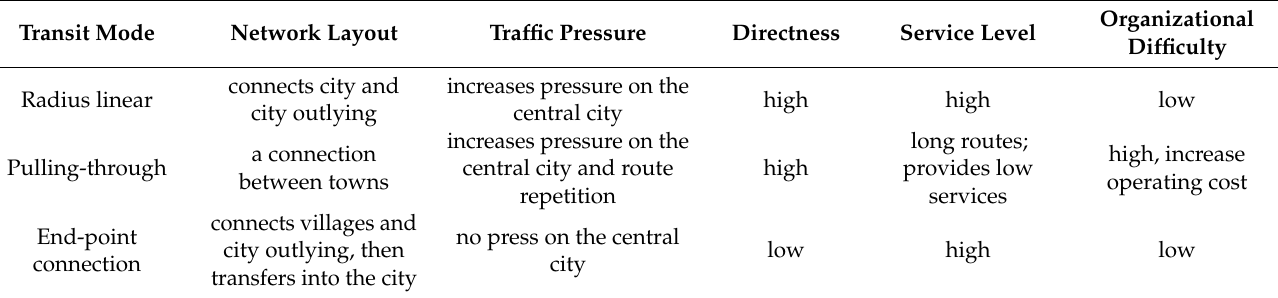
Table 1. Characteristic analysis of layout